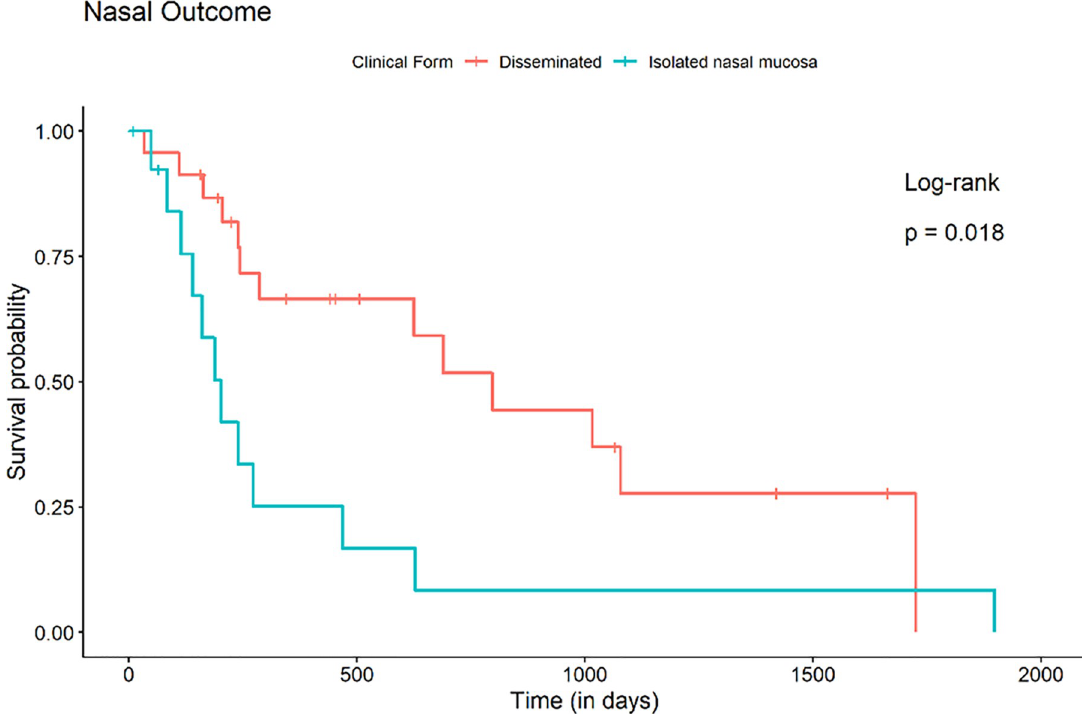
Fig 4. Comparative analysis of cure (Kaplan-Meier survival curve) between patients with isolated nasal mucosa sporotrichosis’ lesion and patients with the disseminated form.